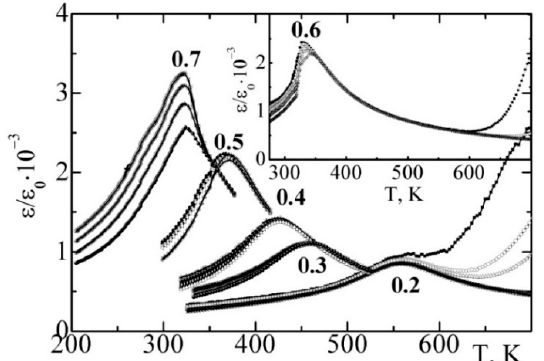
Figure 4. Dependencies ε / ε 0 (T) of ceramic of SS x = 0.2 ÷ 0.7 ( ∆ x = 0.1) in temperatures range T = 200 ÷ 700 K and frequencies f = 200 ÷ 10 6 Hz, obtained in the cooling mode. The arrow shows the direction of growth of f . The numbers on curves corresponds to the values of x .